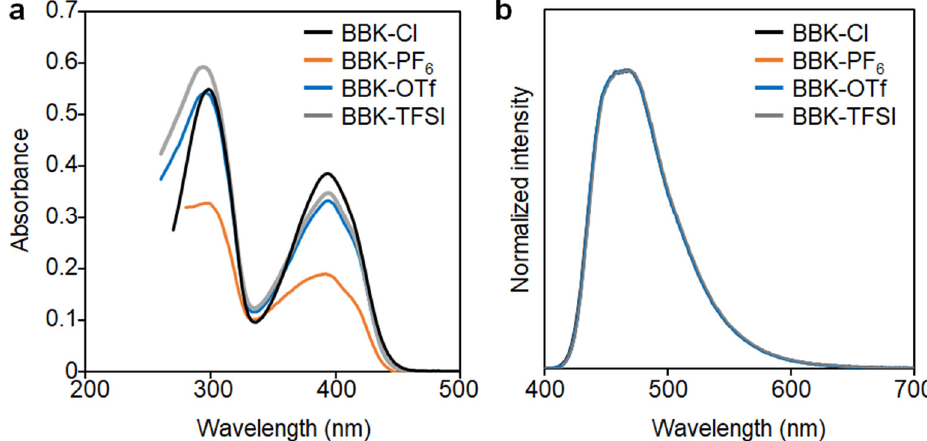
Figure 2. ( a ) UV − vis absorption and ( b ) emission spectra of the ionic salts in CH 2 Cl 2 solution (1.0 × 10 − 5 mol/L). Emission spectra were obtained with the excitation light at λ abs,max .